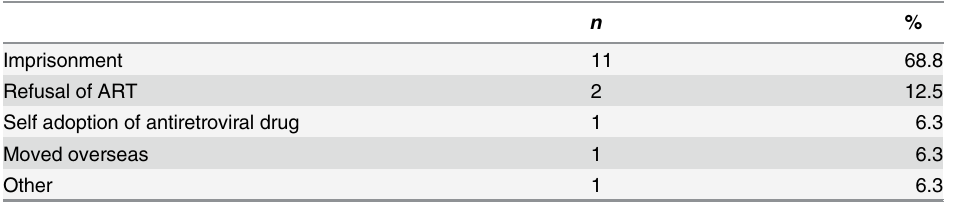
Table 2. Reasons for disengagement from the two